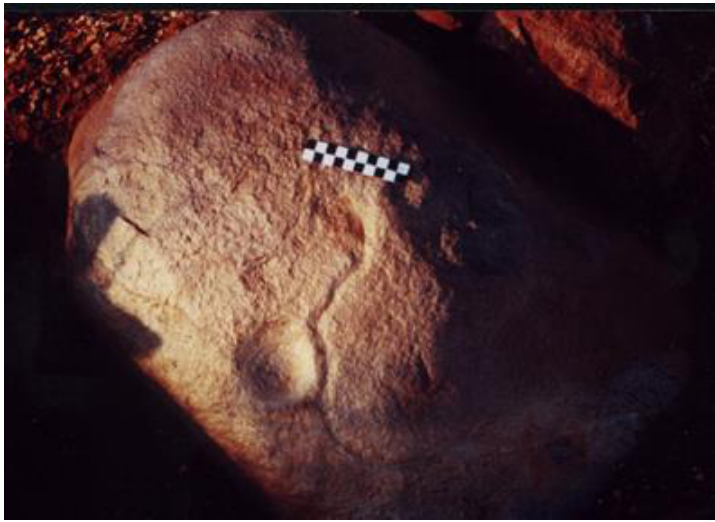
Figure 19. Two petroglyphs covered by Acheulian occupation deposit, Auditorium Cave, Bhimbetka rock art complex, central India.